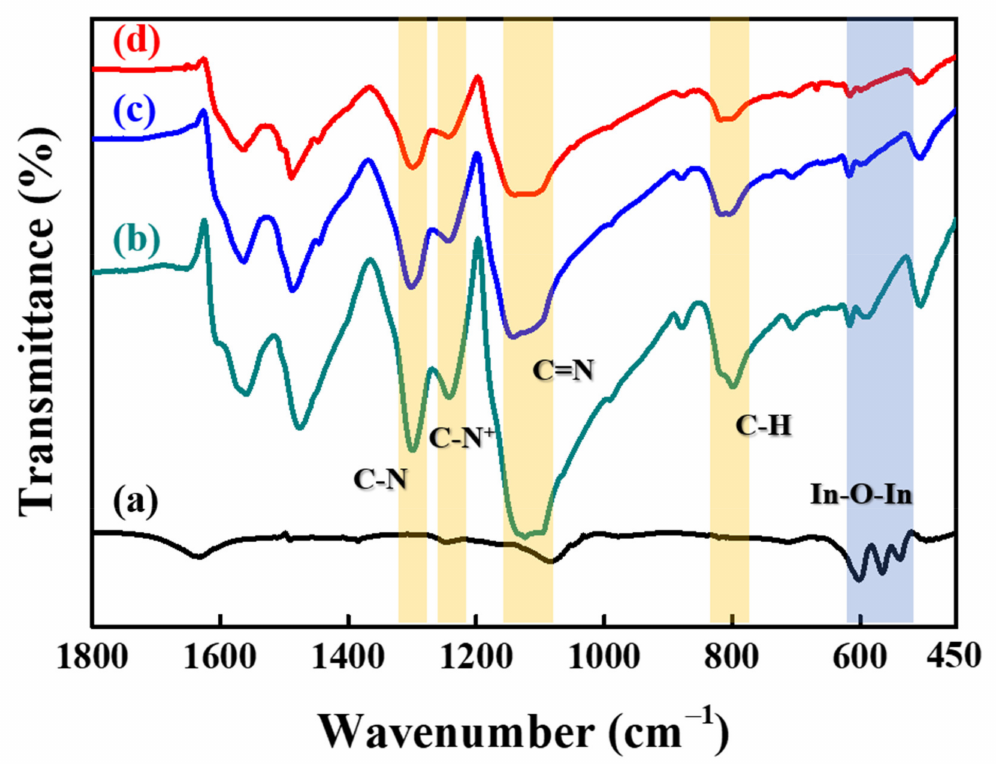
Figure 4. FT-IR spectra of ( a ) hollow In 2 O 3 nanofiber, ( b ) pure PANI matrix, ( c ) PANI/hollow In 2 O 3